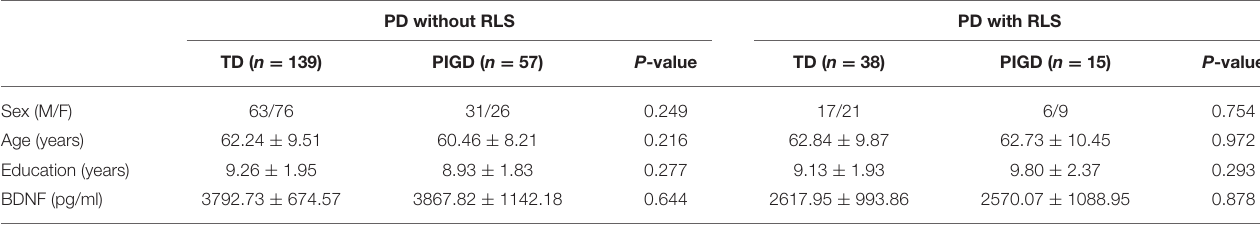
TABLE 2 | Comparison between TD-PD and PIGD-PD motor subtypes on demographic details and BDNF